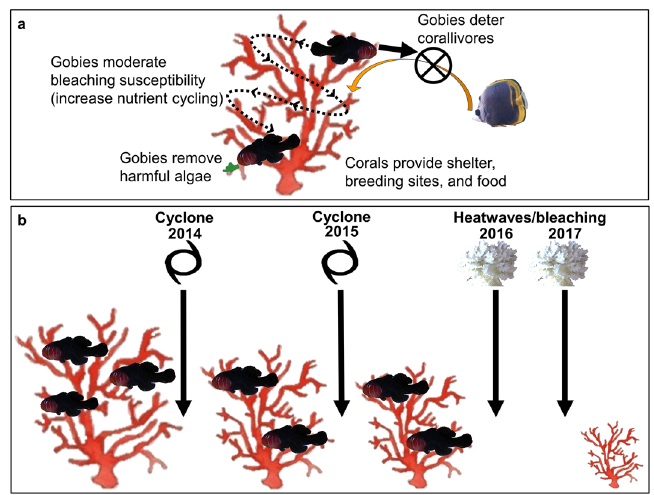
Figure 1. Drastic shifts to the mutual symbiosis of corals and cryptobenthic coral-dwelling gobies following multiple disturbances. ( A ) Benefits that each symbiont receives from the mutual symbiosis 19–21,28,29 . ( B ) Summary of the findings highlighting changes to corals and gobies from each consecutive disturbance with coral-dwelling gobies from the genus Gobiodon in scleractinian corals from the genus Acropora . Reductions in coral size are drawn to scale and relative to changes in means among disturbances. Figures were illustrated in Microsoft Office PowerPoint